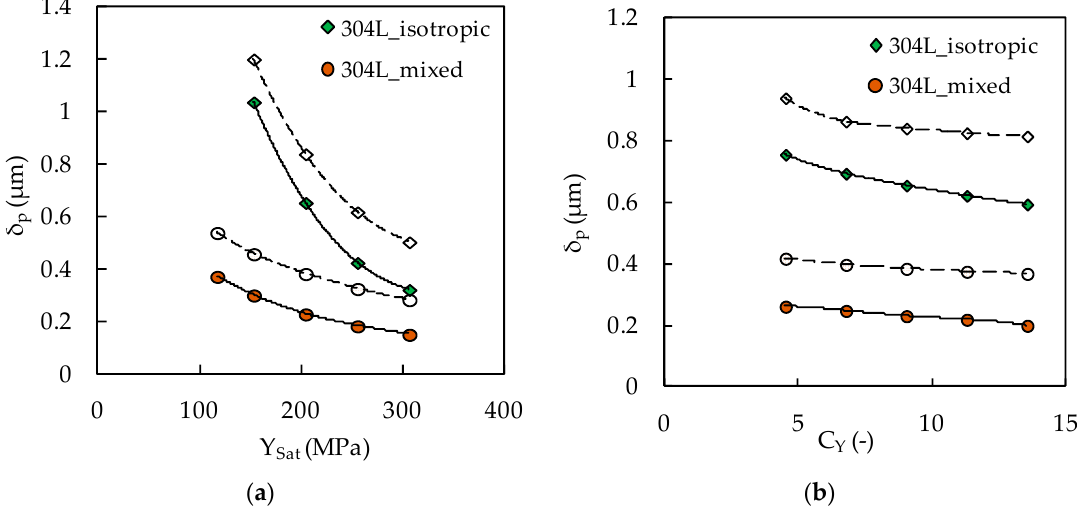
Figure 8. Plastic CTOD range, δ p , vs. ( a ) saturation stress, Y Sat ; ( b ) stress saturation rate, C Y (with crack closure, solid lines; without crack closure, dashed lines).